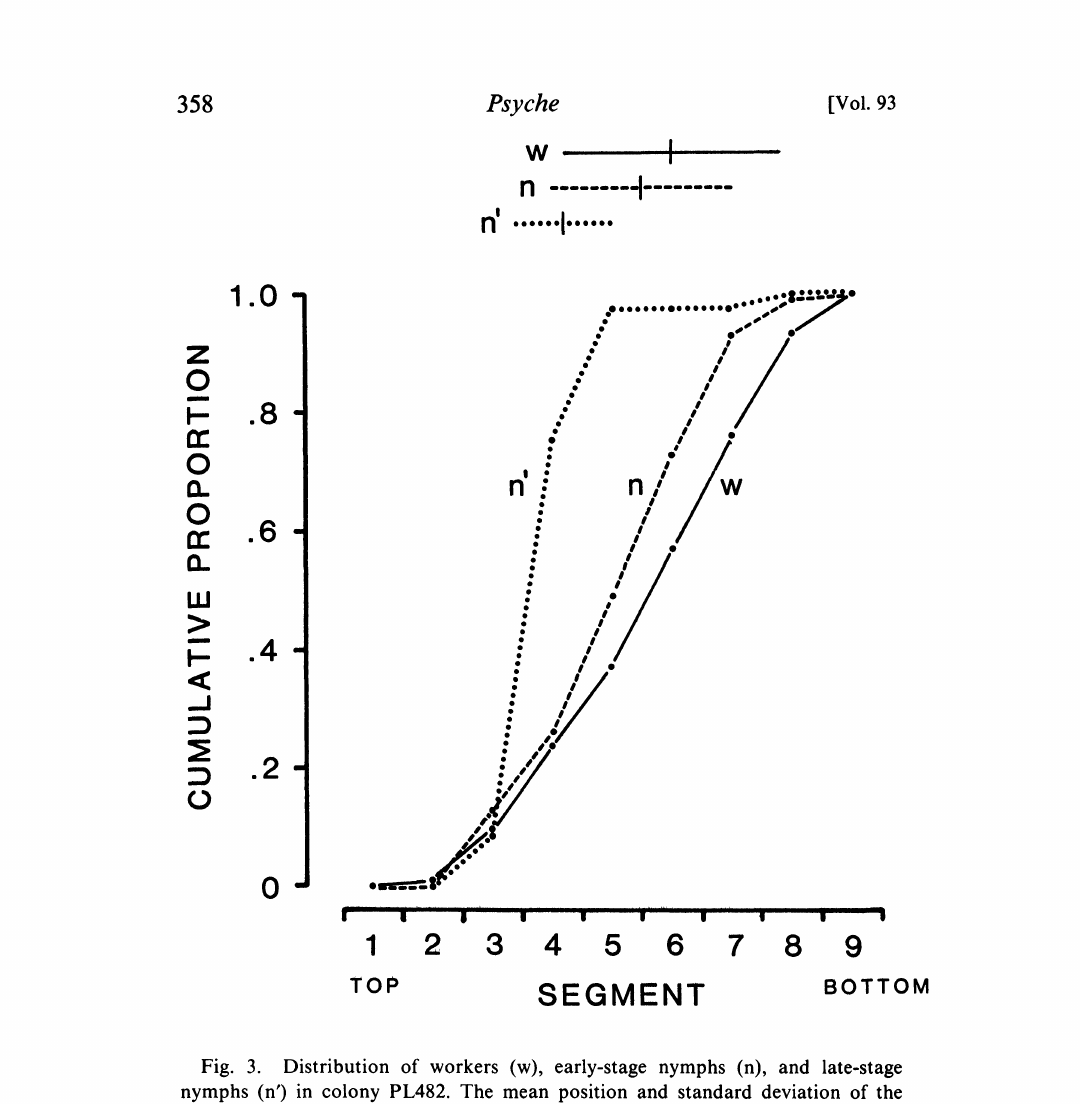
Fig. 3. Distribution of workers (w), early-stage nymphs (n), and late-stage nymphs (n’) in colony PL482. The mean position and standard deviation of the distribution for each caste is indicated by the three lines at the